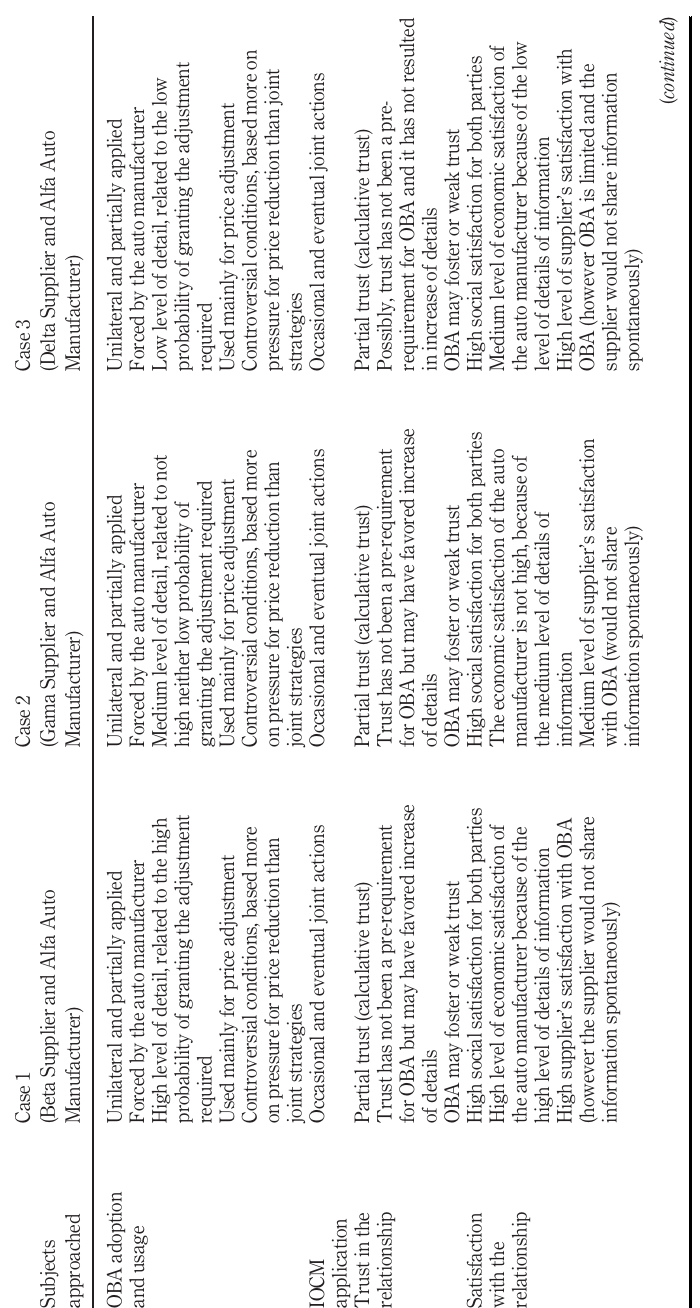
Table VI. Main results of the